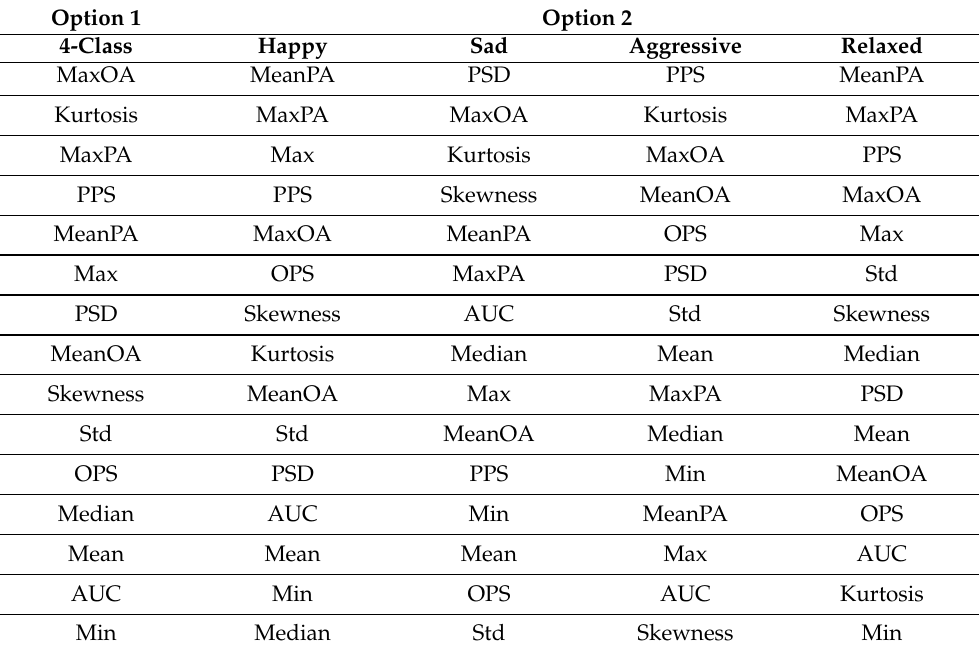
Table 2. Features (explained in Table 1) in order of highest to lowest